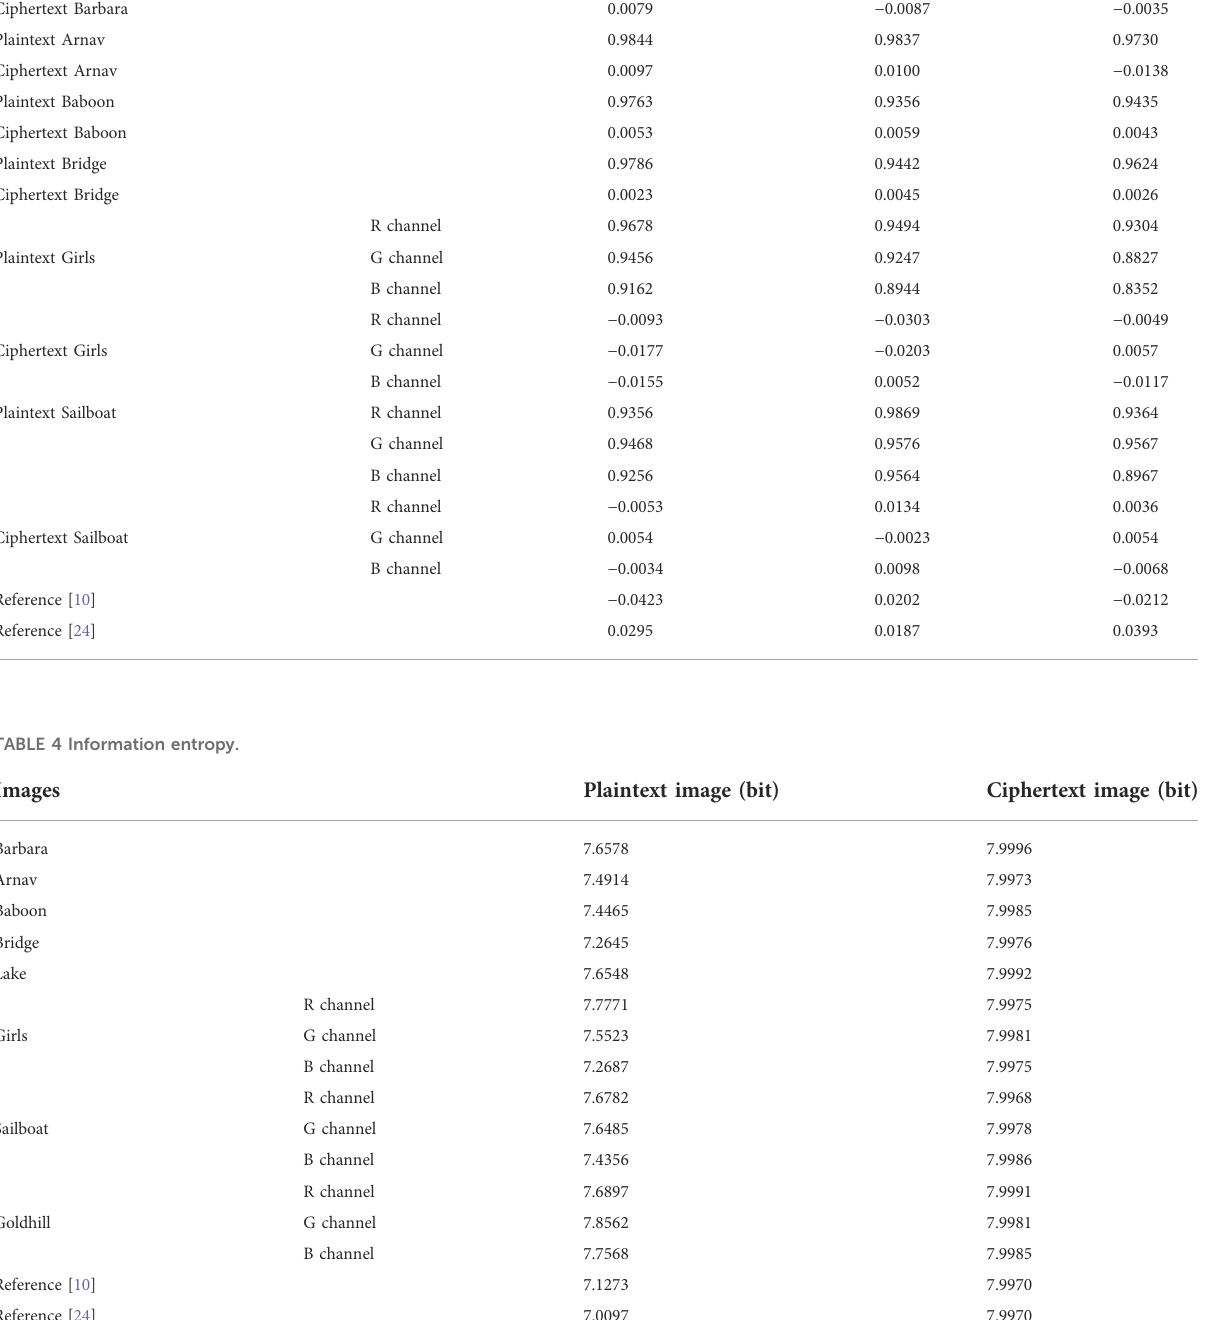
information of the decryption images can still be identi fi ed. Therefore, the proposed encryption algorithm has a certain ability to resist the shear attack.